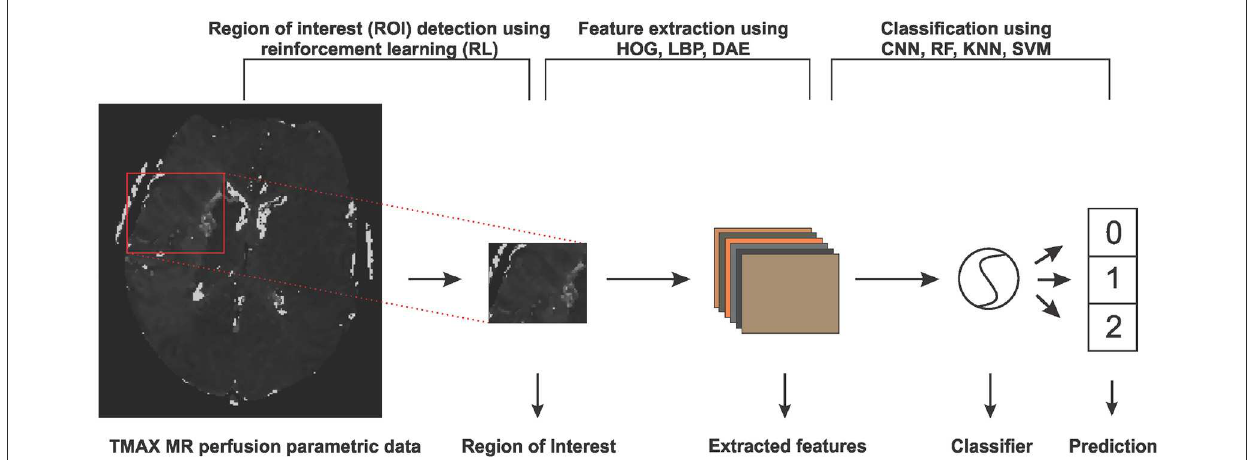
FIGURE1 An overview of the steps involved in predicting collateral flow grading from MR perfusion parametric data. The first step involves a region of interest detection using reinforcement learning, followed by histogram of gradient (HOG), local binary pattern (LBP), and denoising autoencoder (DEA) feature extraction schemes and then the classification step which uses random forest (RF), K-nearest neighbor (KNN), support vector machine (SVM), and convolutional neural network (CNN)